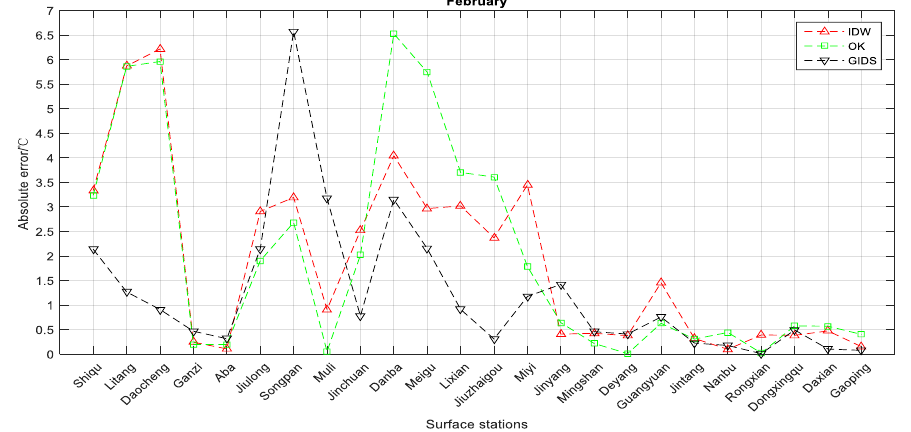
Figure 3 Absolute errors of IDW, OK and